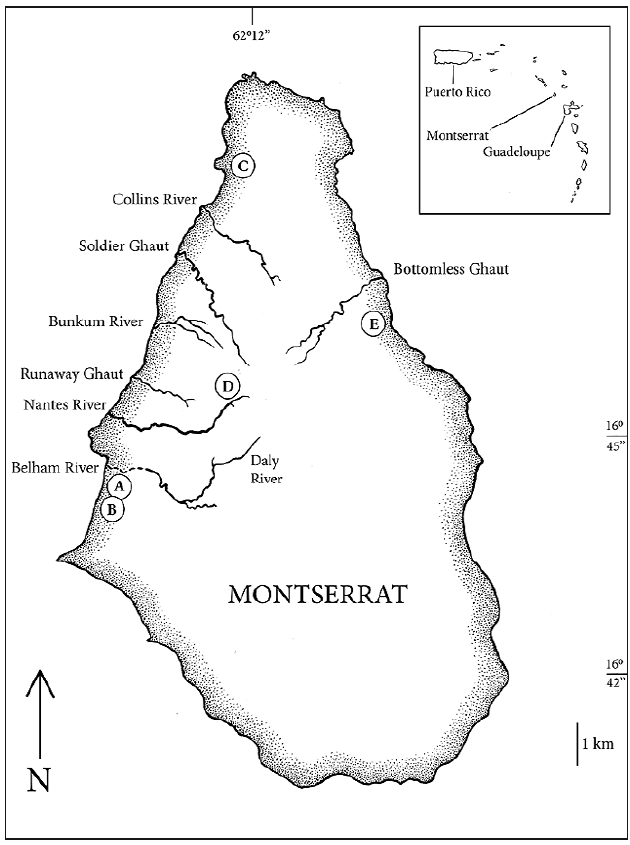
Figure 1. Map of Montserrat showing localities where Gymnophthalmus lizards were collected or observed. (A) Isles Bay 2008, from photograph archived at the Department of the Environment, Montserrat. (B) Fox’s Bay Trail ( A nonymous 2014), photograph and sighting. (C) Rendezvous Bay Trail ( A nonymous 2014), sighting. (D) Headwaters of Nantes River 2016, sighting (RES and N. Shoobs). (E) Beach south of Bottomless Ghaut 2016 (this study), sighting and specimens collected. Inset shows the position of Montserrat relative to Puerto Rico and islands in the Lesser